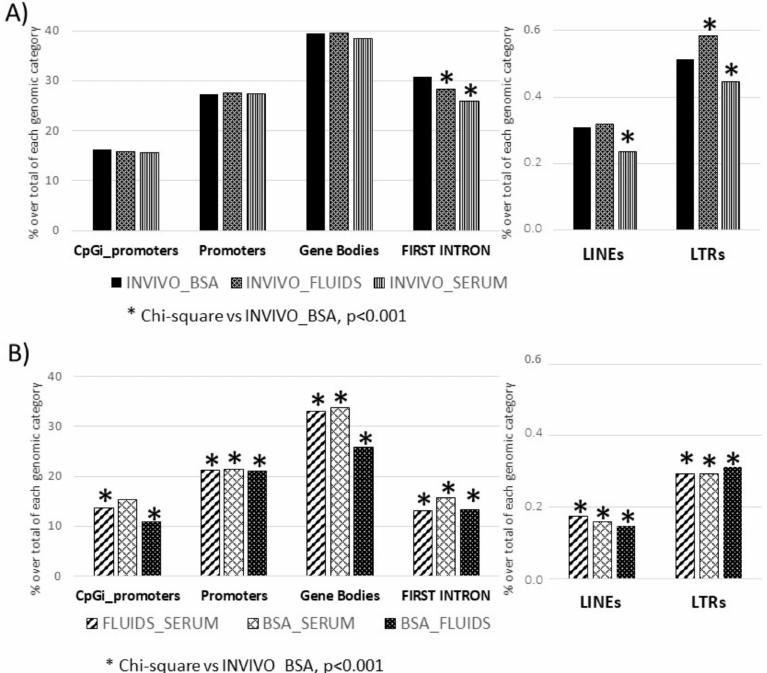
Figure 3. Differentially methylated genomic features after targeted analysis. ( A ) Each invitro group (BSA, FLUIDS and SERUM) was compared vs. INVIVO group. Frequency distribution of DMTs in INVIVO vs. BSA was the reference for Chi-square analysis. ( B ) Differentially methylated genomic features for pair wise comparisons between in vitro